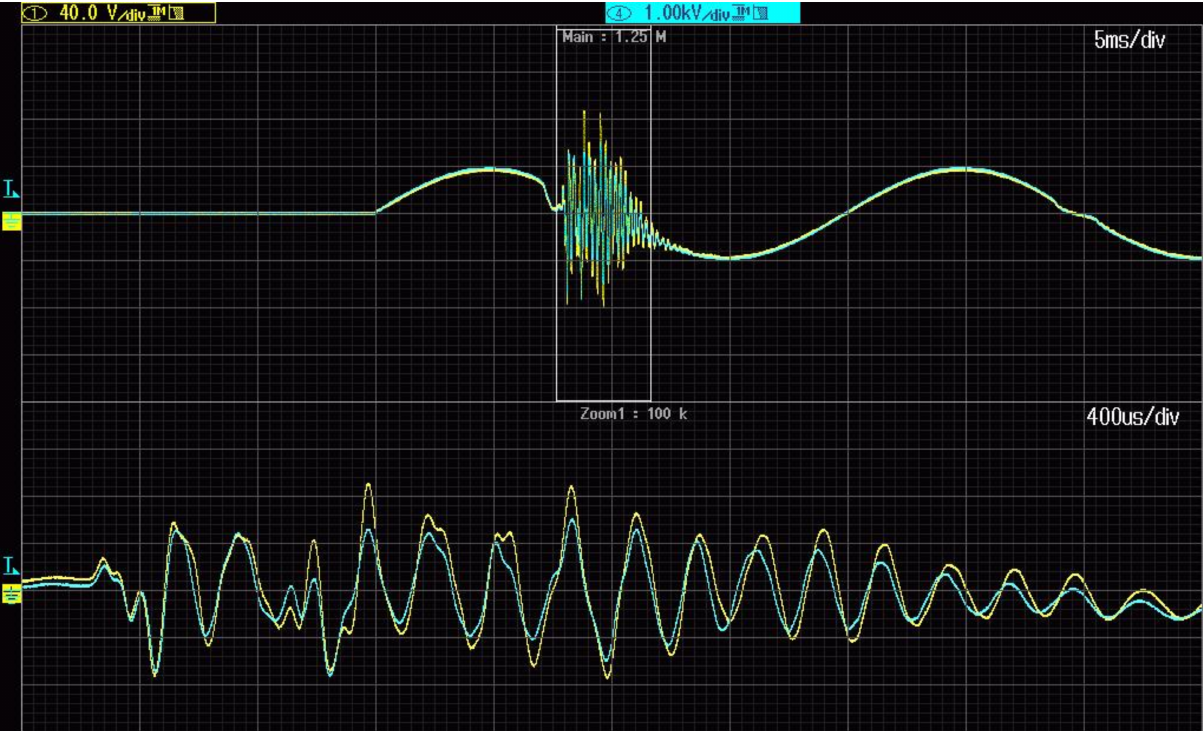
Figure 8. Voltage waveforms of voltages on primary (blue line) and secondary (yellow line) windings of the 20 kV voltage transformer (model 2).